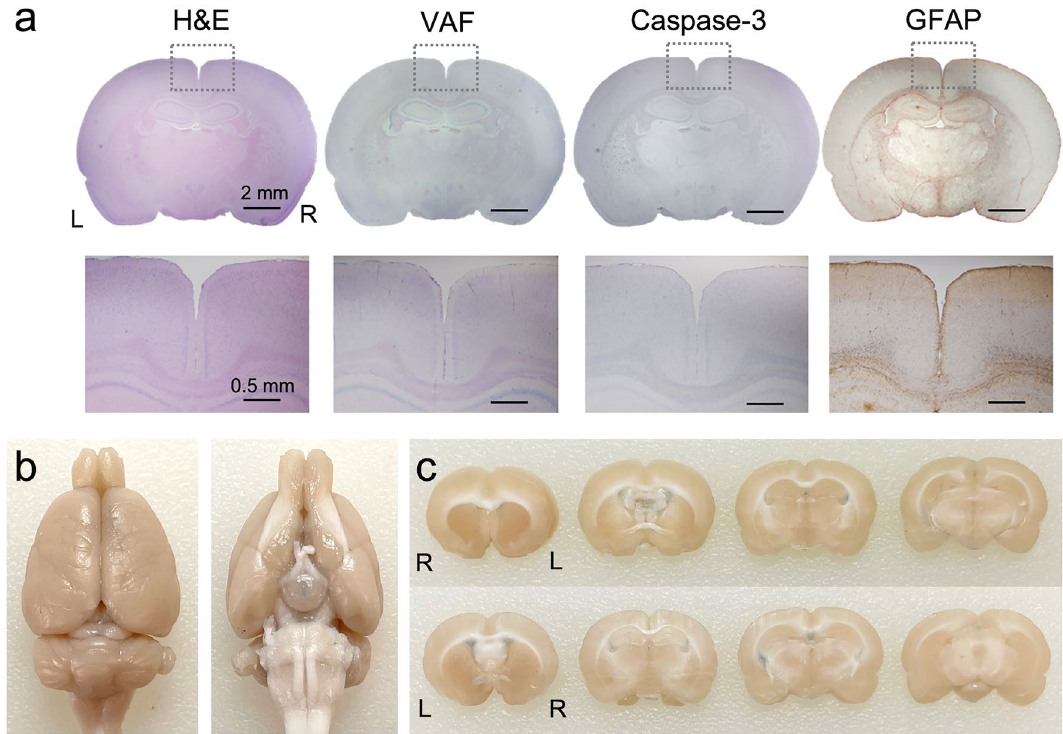
Figure 6. Exemplary histology analysis results of brain tissues and evaluation of blood–brain barrier disruption. ( a ) Top row: H&E, VAF-toluidine blue, caspase-3 and GFAP (from left to right column) stained microscopic images of sonicated brain slices. bar = 2 mm, Bottom row: magnified images from the defined region-of-interest (dotted rectangles). bar = 0.5 mm ( b ) Tail vein injection of trypan blue immediately after FUS sonication revealed no signs of blood–brain barrier disruption in a gross brain specimen and ( c ) 2 mm-thick coronal brain sections shown in rostral and caudal sides. L = left; R =